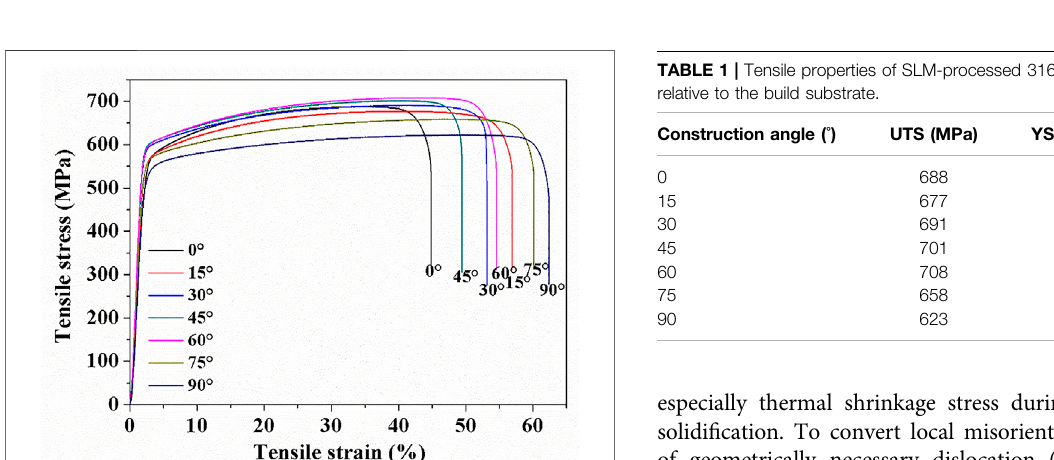
FIGURE 7 | KAM map of SLM-processed 316L SS from different angles relative to the build substrate: (A – D) angle of 0, 45, 60, and 90.